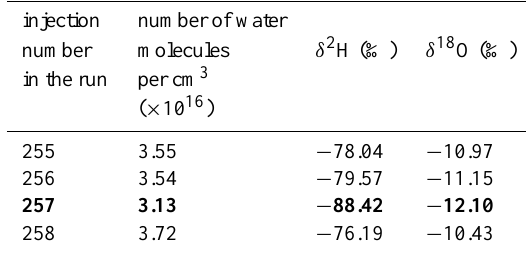
Table 5. Number of water molecules generated for four subsequent injections and the corresponding reportable delta values. In bold: the injection with an inconsistent number of water